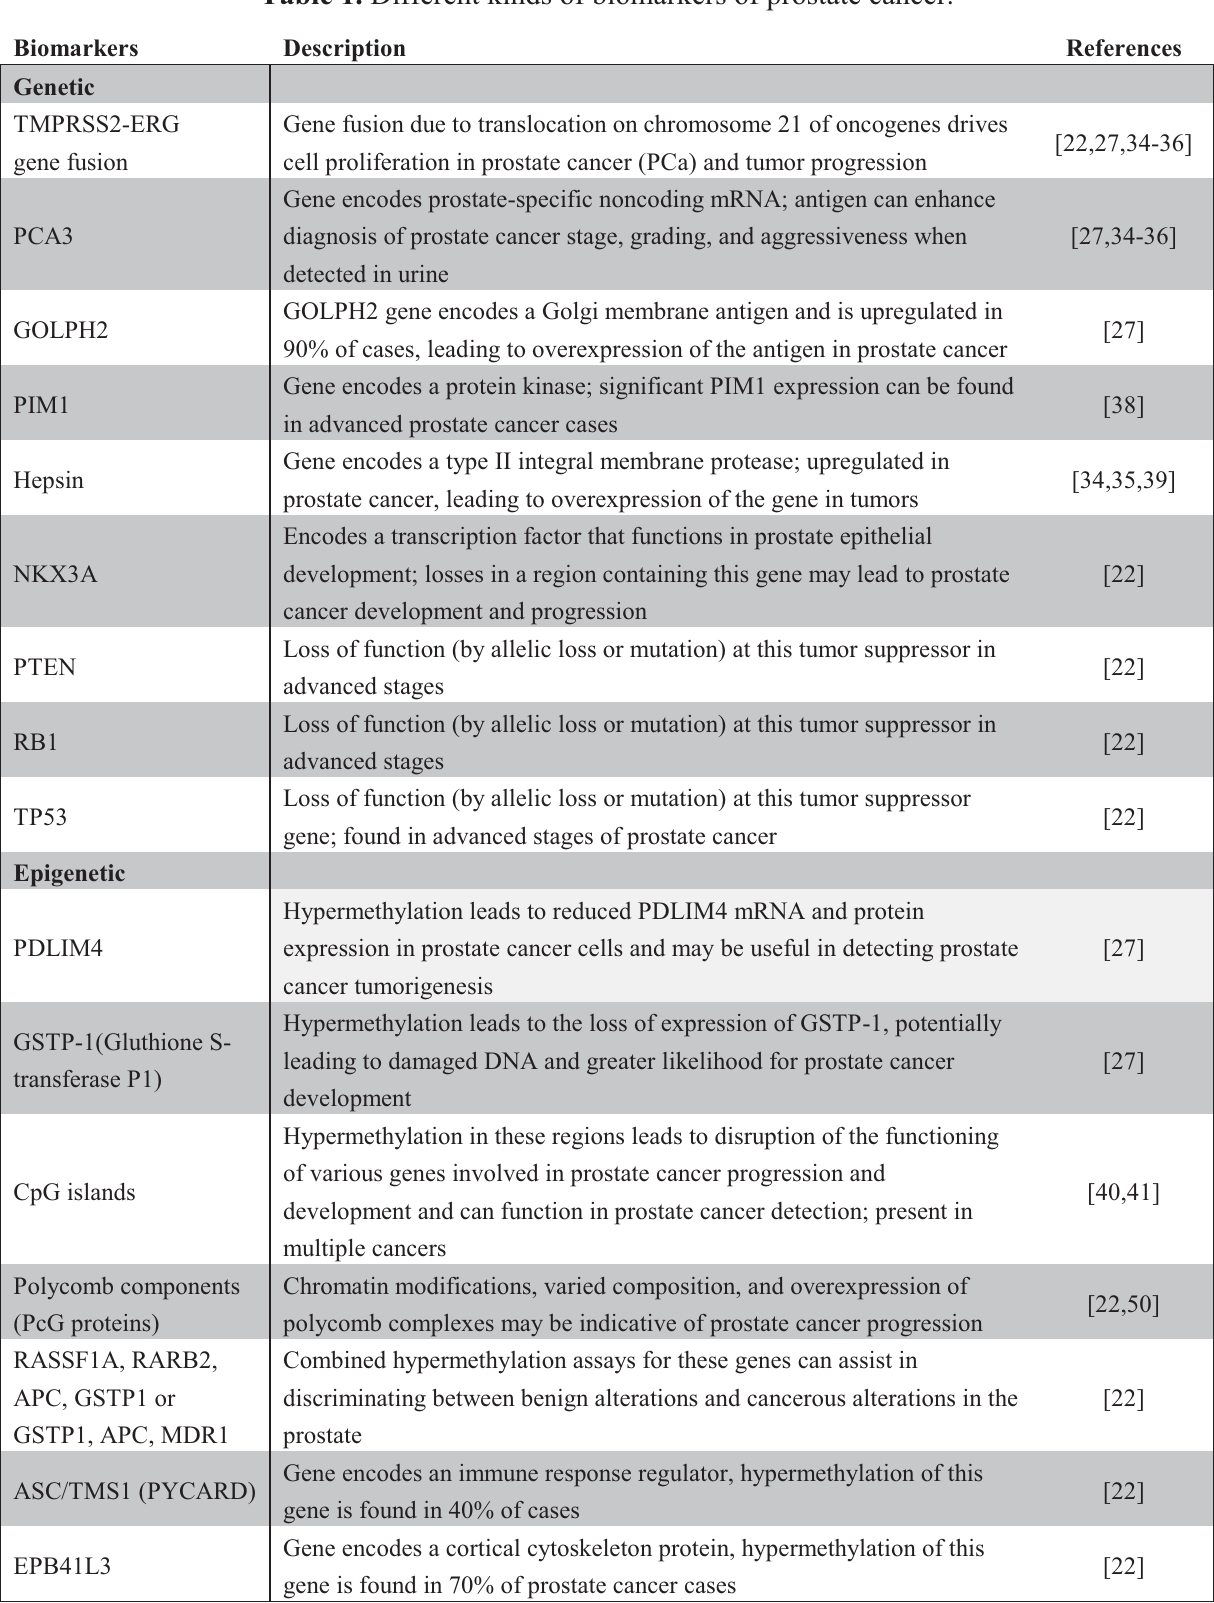
Table 1. Different kinds of biomarkers of prostate